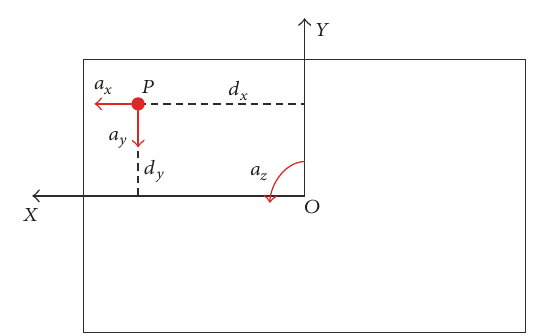
Figure 9: Representation of a point 𝑃 for acceleration